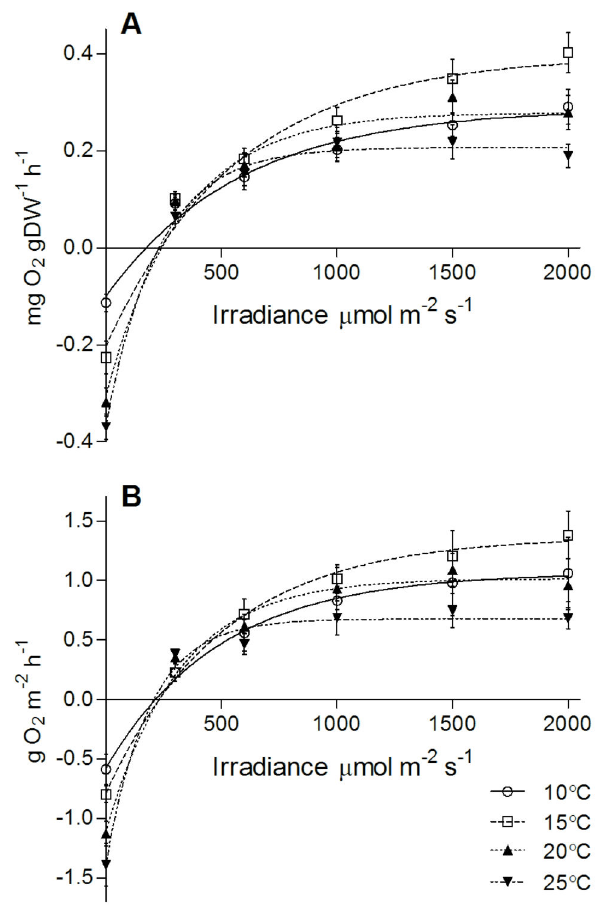
Figure 3. Response of NPP (±SE) in the laboratory to rising temperatures in macroalgal assemblages dominated by H. banksii at four treatment temperatures 10, 15, 20 and 25°C. Curves for each temperature are fitted with rectangular hyperbole. Data are standardized by (A) dry weight of algal material (mg O gDW -1 h -1 ) and (B) area of substrate (g O 2 h -1 ).